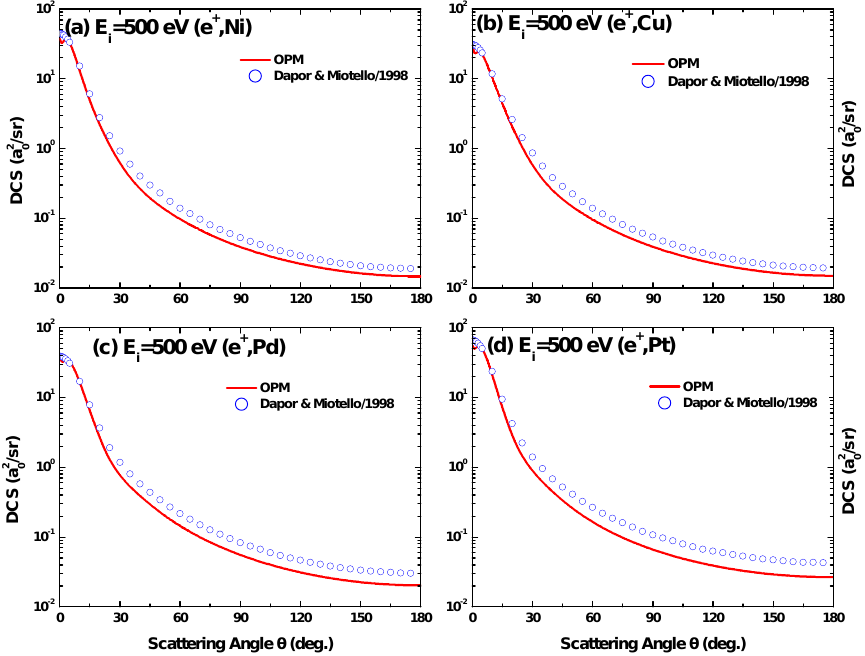
Figure 22. Angular dependence of the differential cross-sections for 500 eV positron scattering from ( a ) Ni 58 , ( b ) Cu 63 , ( c ) Pd 108 , and ( d ) Pt 196 calculated from our OPM approach in comparison with the results of Dapor and Miotello